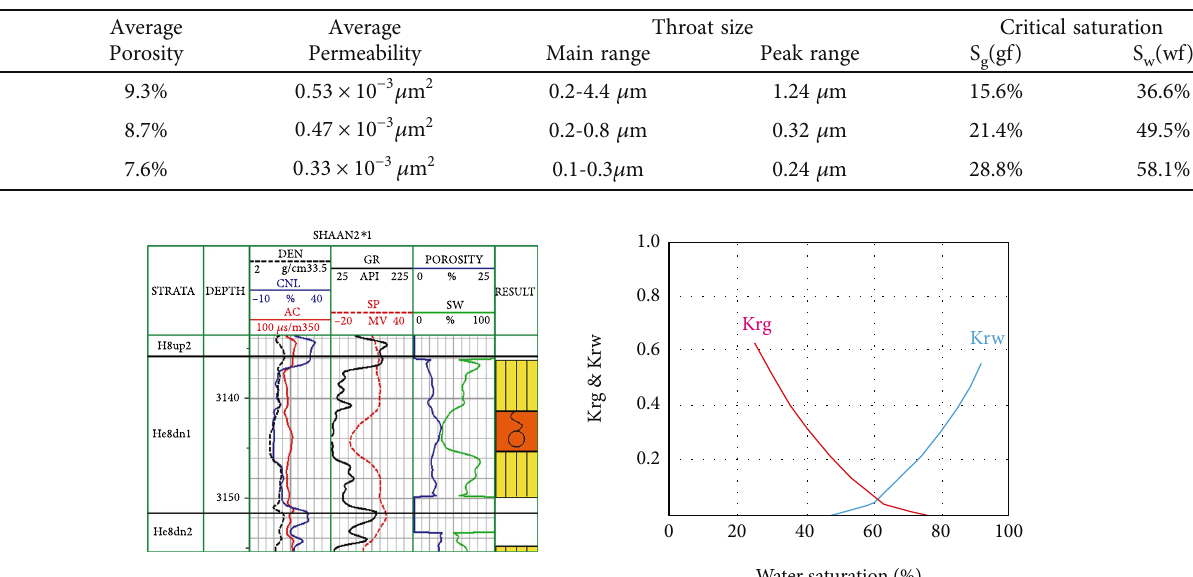
Table 2: Reservoir parameters and critical saturation of three di ff erent types of seepage curves.